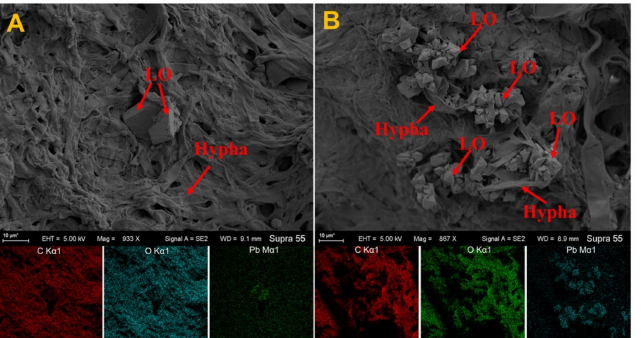
Figure 5. SEM image and EDS mapping data in 1000 mg/L ( A ) and 1500 mg/L ( B ) Pb concentrations after five days of incubation. LO: lead